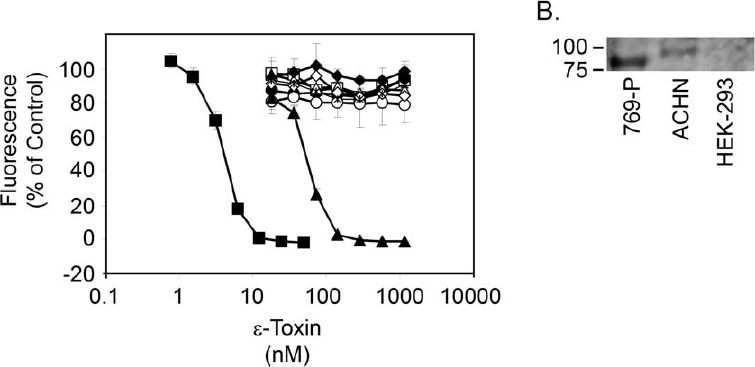
Figure 3. ACHN cells are sensitive to e -toxin. A . Cell lines, including human kidney cell lines expressing HAVCR1 based on publicly-available microarray data or literature searches, were treated with serial dilutions of purified e -toxin. The canine kidney cell line MDCK ( & ) was included as a positive control; HeLa ( e ) and HEK-293 (x) cells were included as negative controls. Other cell lines were 769-P ( % ), 786-O ( Caki-1 ( n ), and G-402 ( ¤ ). Cell viability was assessed as described in the Materials and Methods. Results represent the mean and standard deviation of quadruplicate samples. B . Whole-cell lysates from e -toxin-sensitive ACHN and e -toxin-resistant 769-P and HEK-293 cells were prepared and equal volumes of samples were analyzed by immunoblot analysis using an anti-HAVCR1